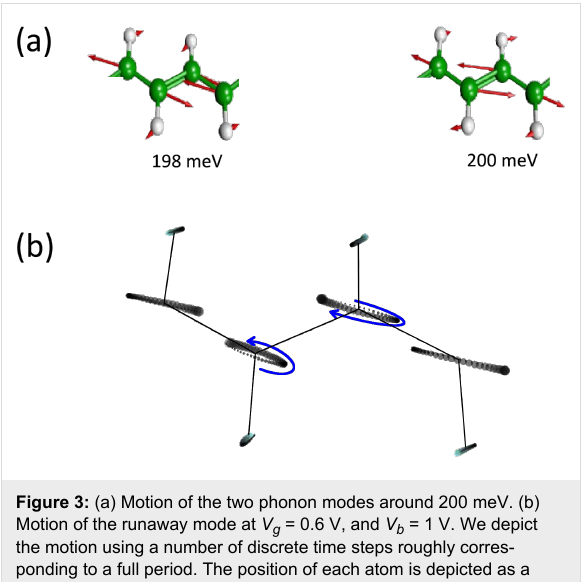
The effect of the NC and BP forces is to couple different phonon modes with nearly similar frequencies. From now on, we will focus on the two phonon modes around 200 meV, shown in Figure 3, since the alternating-bond-length-type modes (200 meV) couple most strongly with the electric current. This type of mode also gives rise to the most intensive Raman signals in unpassivated chains between graphene-like pieces [41].